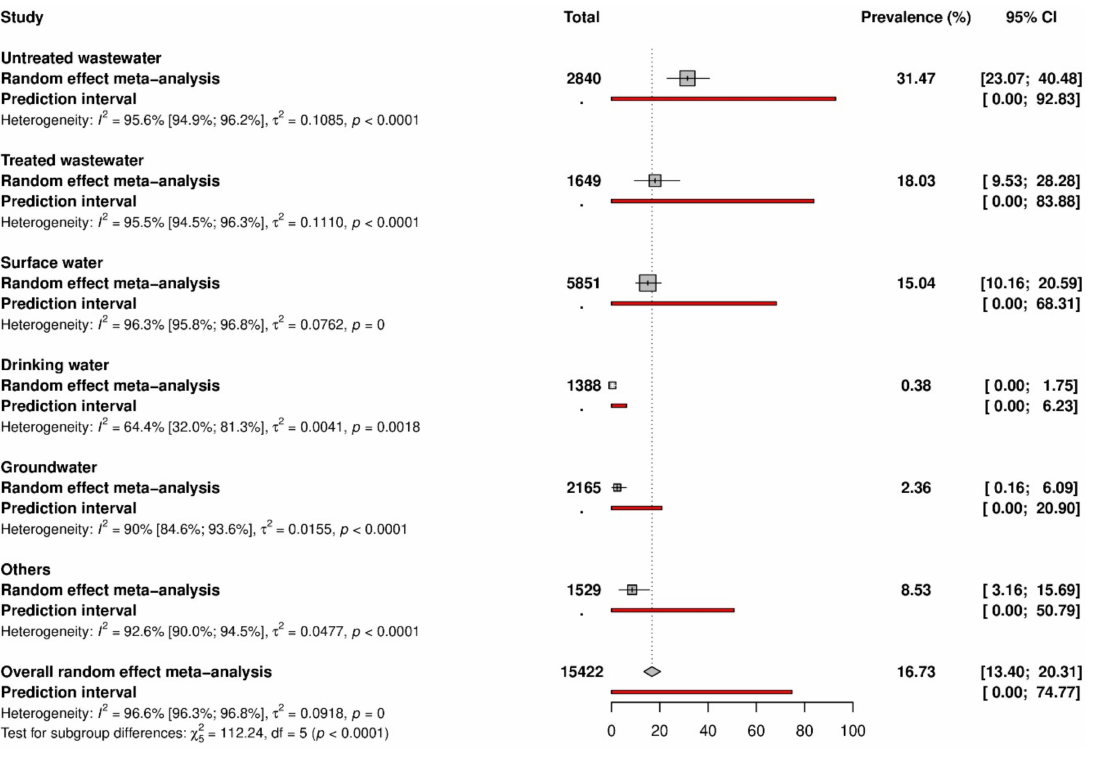
Figure 2. Data on HAV